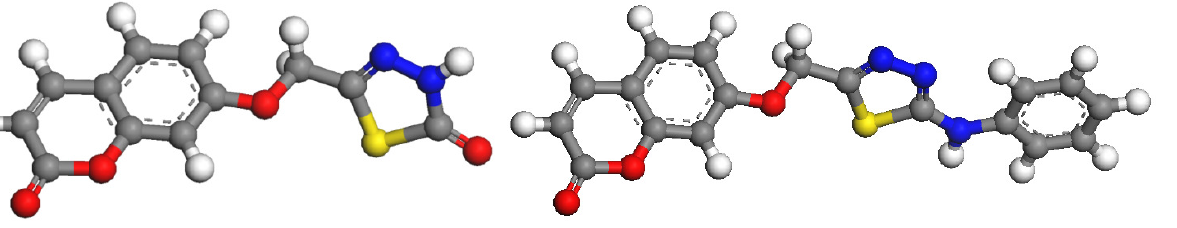
Figure 3. Optimized molecular structures of 5 and 8 by DFT.